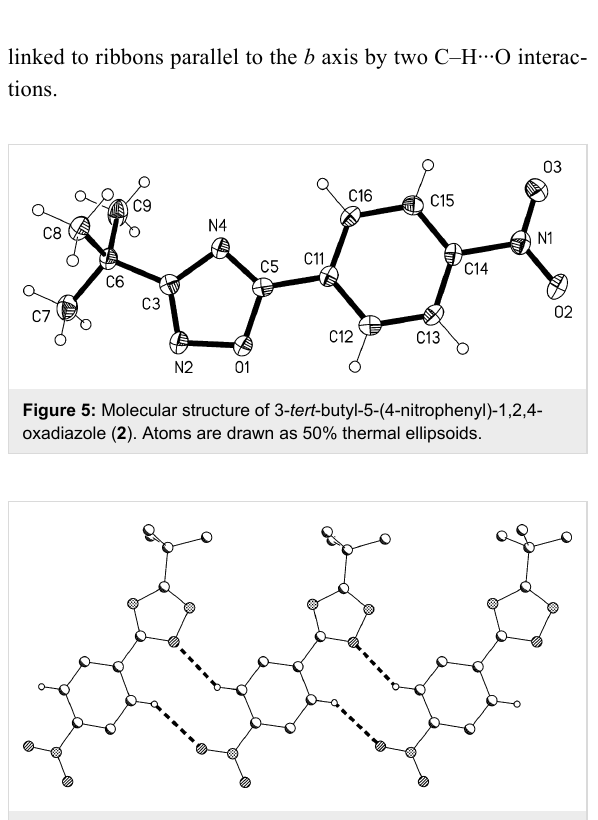
Figure 6: Packing diagram of compound ( 2 ) showing C–H···O interac- tions.